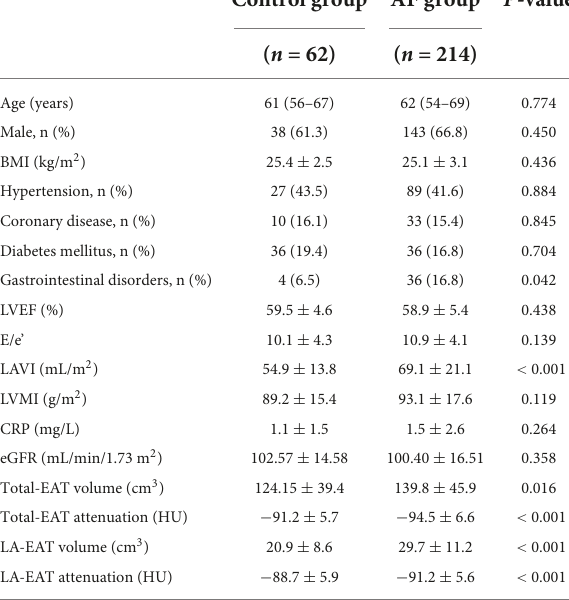
TABLE 2 Comparison of clinical and anatomic variables in patients with and without LVZ in atrial fibrillation.